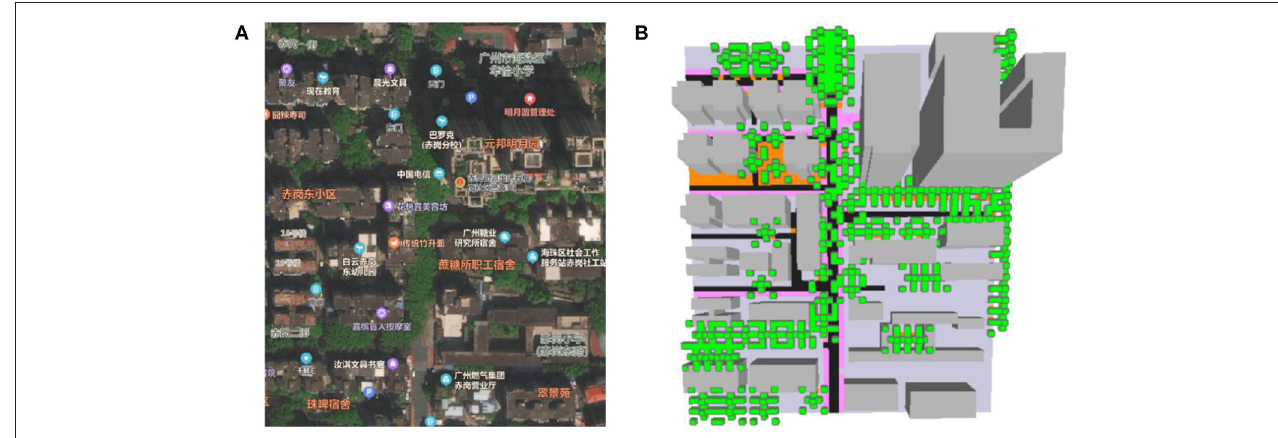
FIGURE 3 | Satellite image (A) and model image (B) of Chigang community.